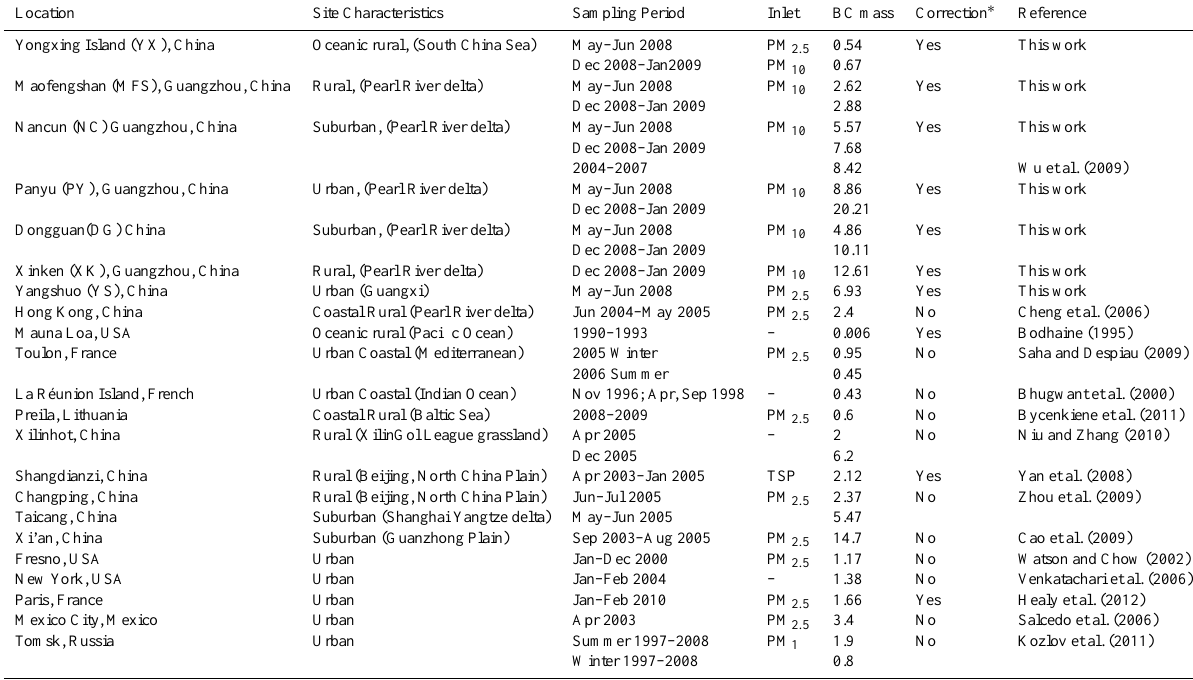
Table 2. Comparison of BC concentrations (µgm − 3 ) obtained by Aethalometers at different locations in the world. Location Site